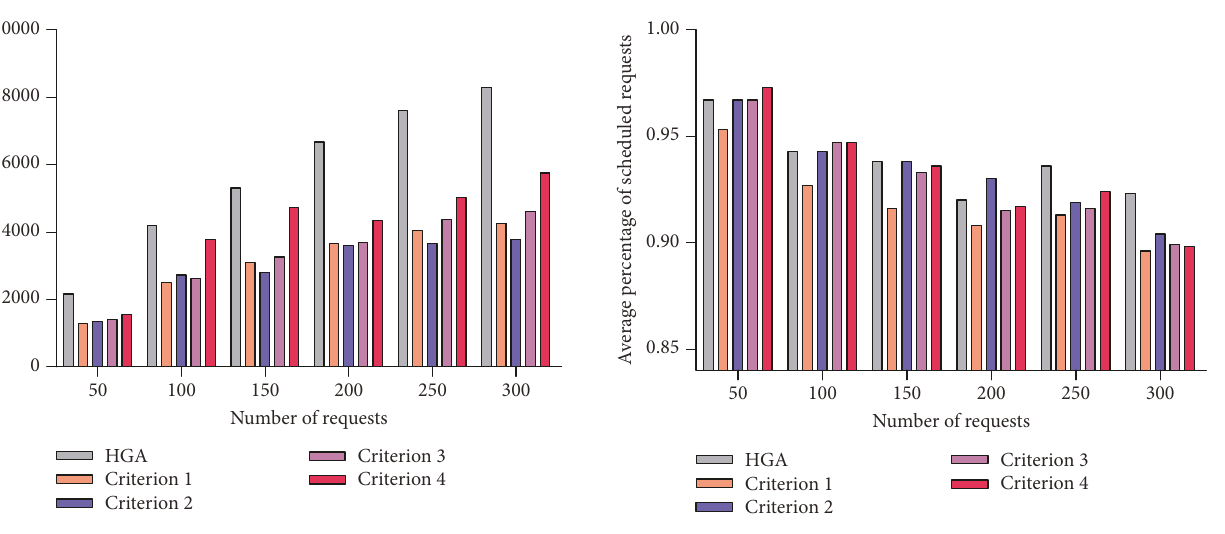
Figure 5: Average pro fi t of di ff erent algorithms. Figure 6: Average task